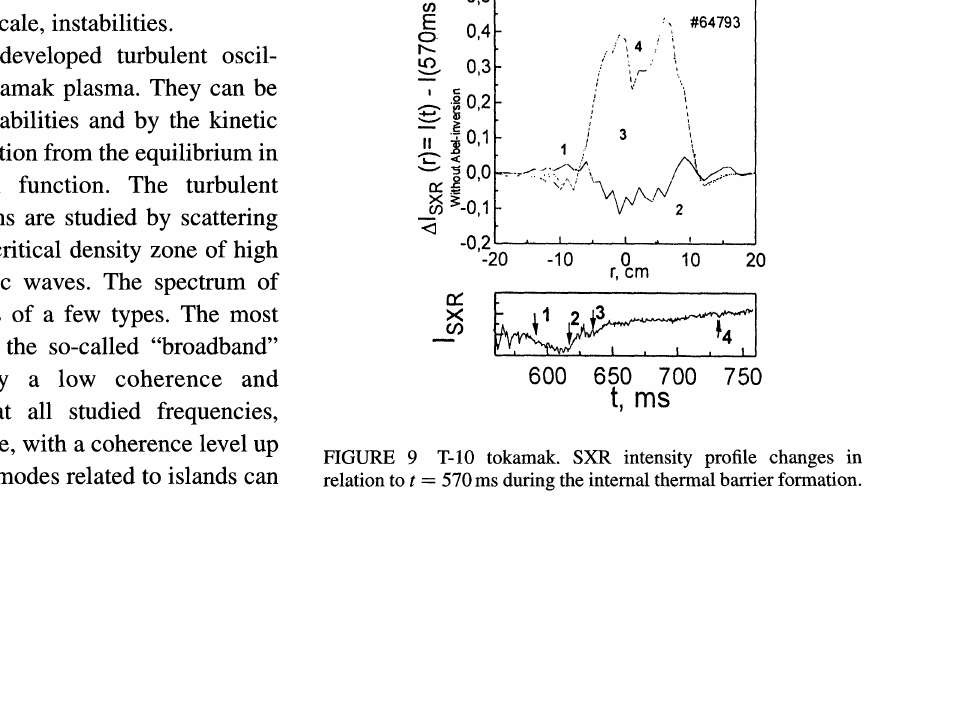
FIGURE 8 T- 10 tokamak. Temporal behavior of Te(0) in the same situation as in Fig. 7, but for the conditions when qmin increase more rapidly from the beginning of the discharge to its end. One can see the transitions at qmin approaching values of 1.5 and then 2.